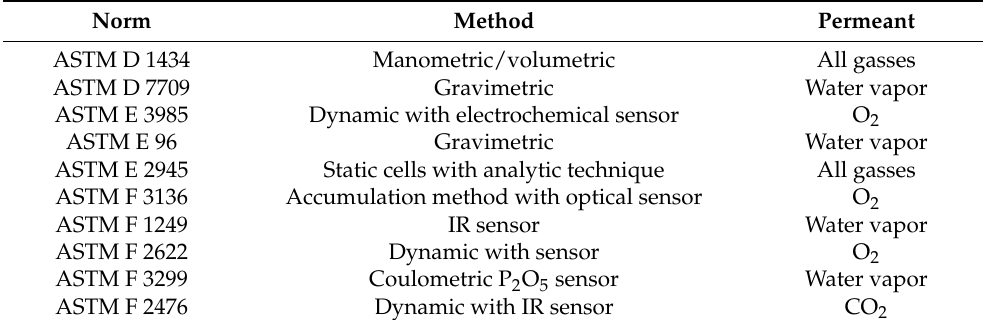
Table 1. ASTM standard methods for the determination of gasses and water vapor permeability in polymeric food